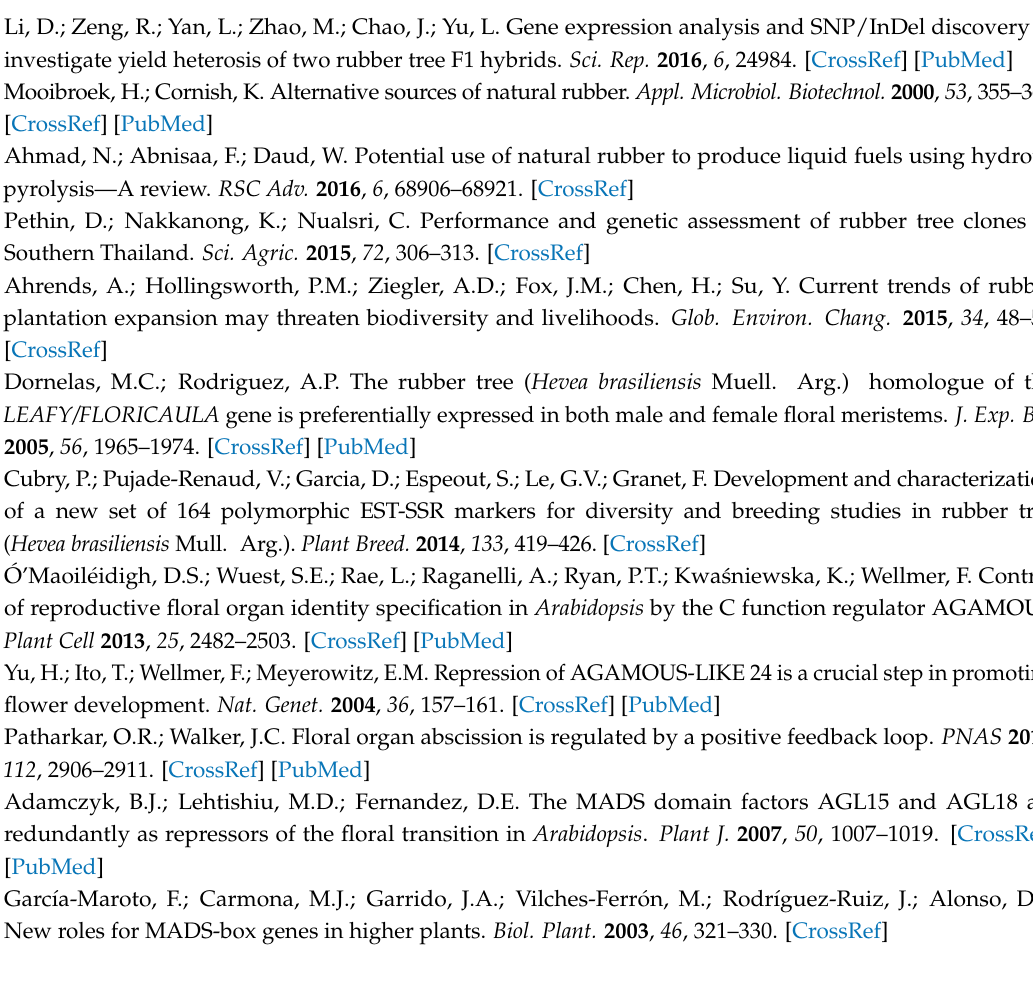
Supplementary Materials: The following are available online at www.mdpi.com/1999-4907/9/6/304/s1, Figure S1: Tissue samples of rubber tree flowers, Figure S2: The conserved domain logo and motif composition of HbMADS-box genes, Figure S3: Exon-intron structures of HbMads-box genes, Figure S4: Expression profiles of the floral-enriched HbMad-box genes under cold stress, Figure S5: Expression profiles of the floral-enriched HbMad-box genes under high temperature stress, Figure S6: Expression profiles of the floral-enriched HbMad-box genes under drought stress, Figure S7: Expression profiles of the floral-enriched HbMad-box genes under salt stress, Figure S8: Expression profiles of the floral-enriched HbMad-box genes responding to ABA treatment, Figure S9: Expression profiles of the floral-enriched HbMad-box genes responding to GA3 treatment, Table S1: List of primer sequences used for HbMad-box TFs amplification, Table S2: List of primer sequences used for qRT-PCR analysis, Table S3: Sequence features of AtMADSs in A. thaliana . (L.) Heynh. Gene IDs, protein length, PI, and molecular weight of corresponding AtMADSs in A. thaliana are shown, Table S4: Percent identity matrix of HbMad-box TFs proteins, Table S5: Statistics of exon and intron number distribution among HbMad-box TFs. Author Contributions: M.W. and W.L. designed the experiments. R.P. performed the tissue and organ